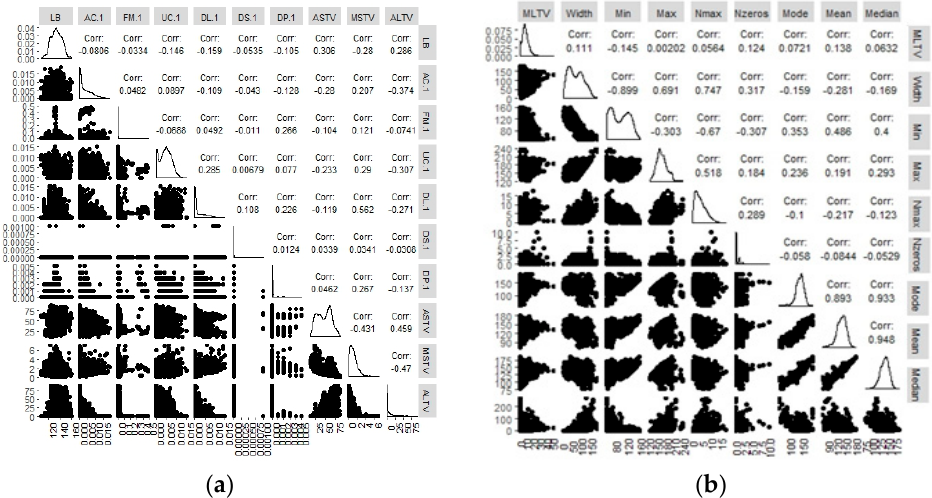
Figure 1. A depiction of correlation among different attributes of the CTG dataset, including LB, AC, FM, UC, DL, DS, ASTV, MSTV, and ALTV, in addition to min, max, width mode, mean and median of the FHR histogram.